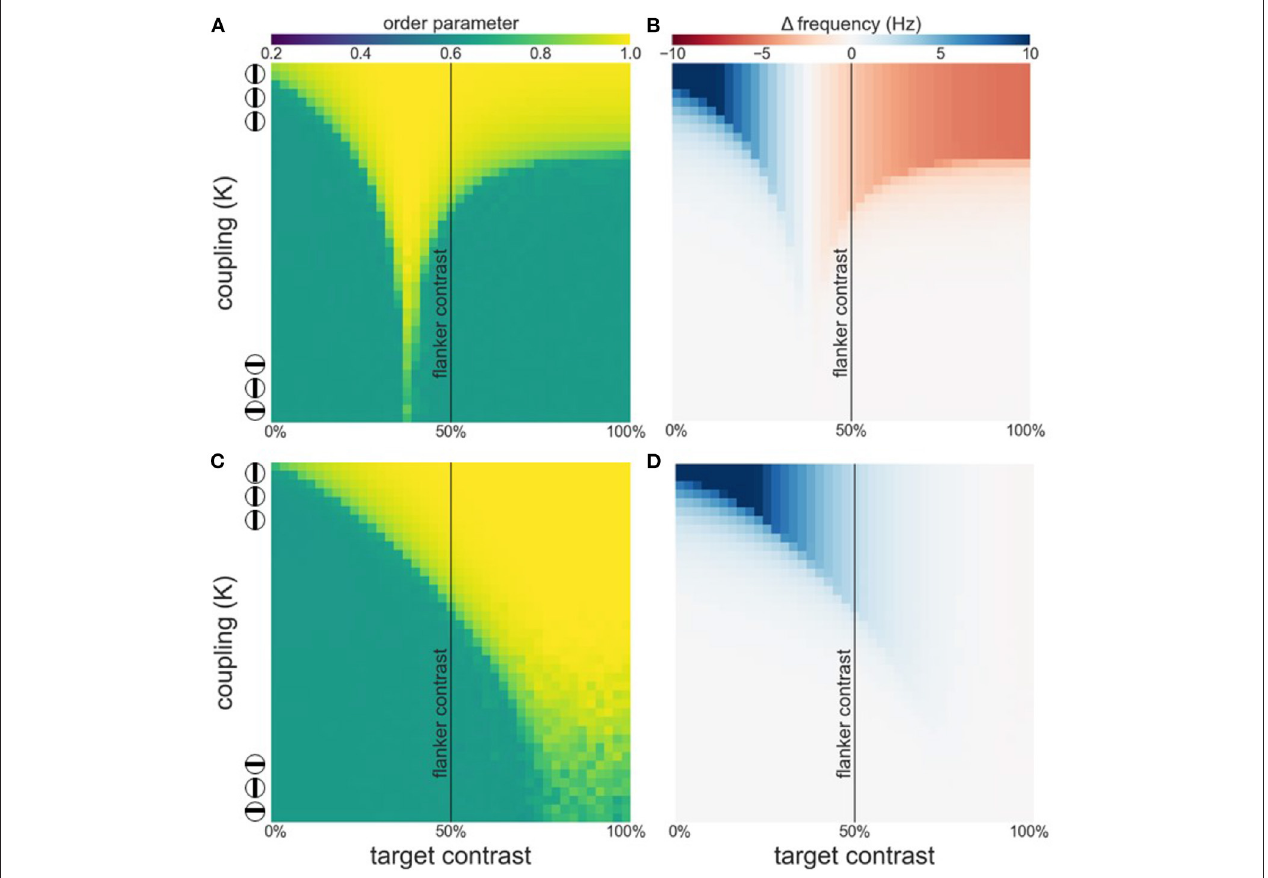
FIGURE 5 | Effects of attention on phase coherence (A,C) and frequency difference (B,D) . (A,B) Attention on the target. (C,D) Attention on the flankers. Flanker contrast is fixed at 50% (vertical line).